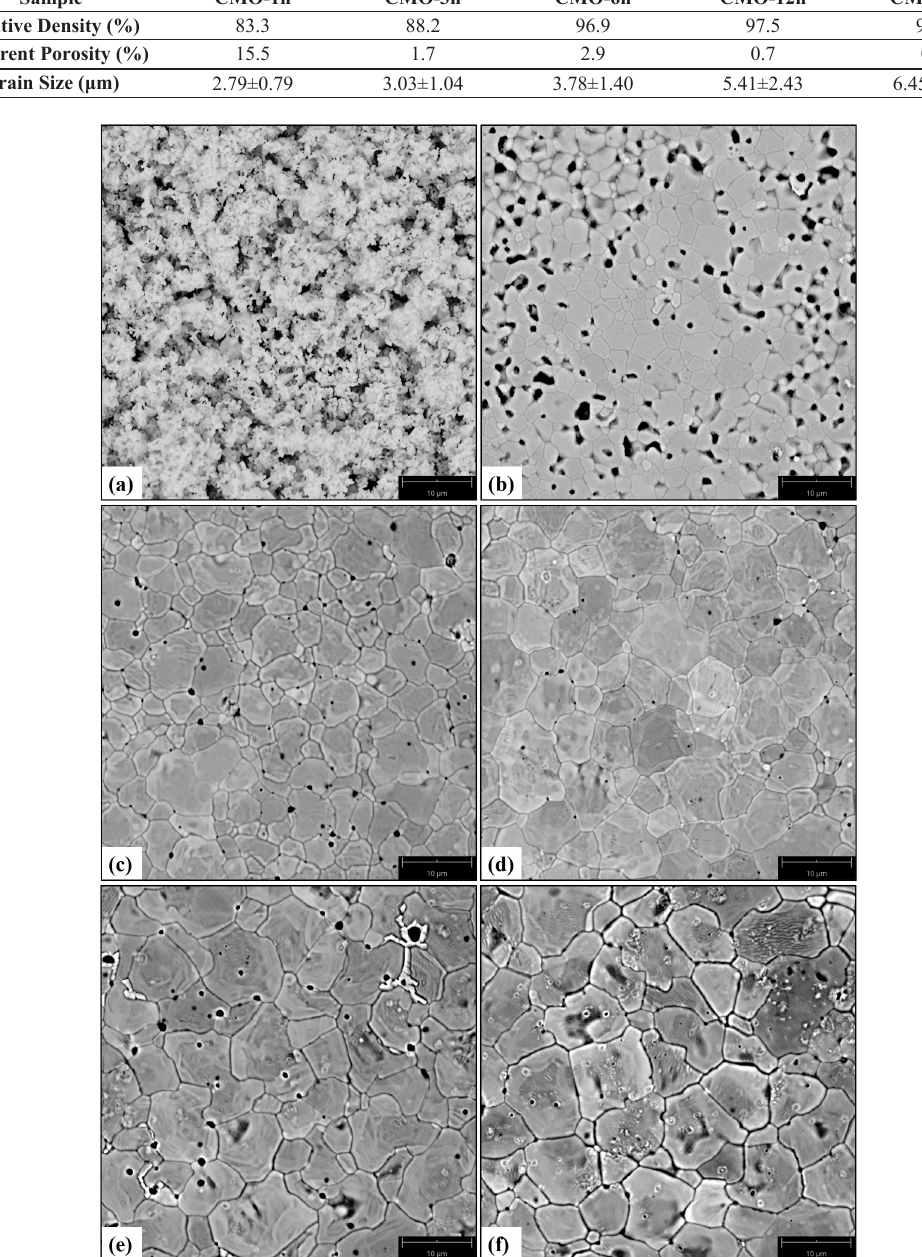
Table 2. Relative density, apparent porosity and grain size for CMO ceramics sintered with different holding time.